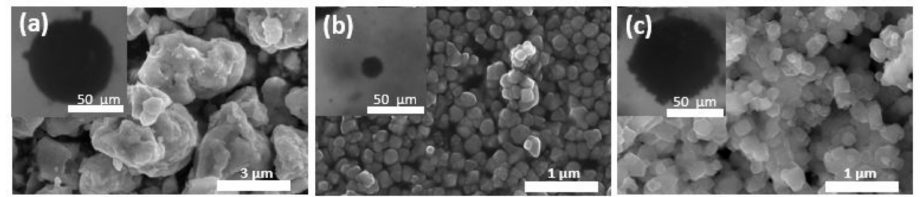
Figure 1. Scanning electron microscopy data for ( a ) OA-MPs, ( b ) nMPs, and ( c ) µ MPs. The inset images present examples of emulsion droplets coated by these particles after stabilization in an electric field.